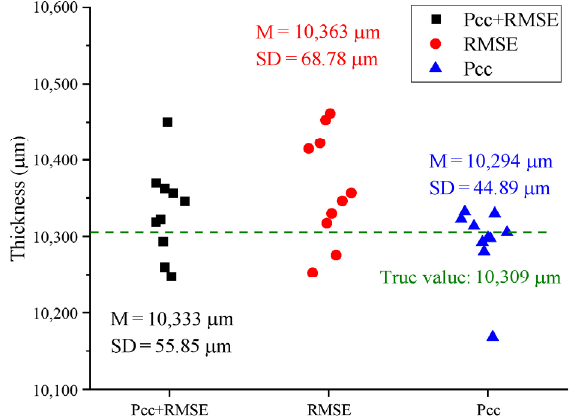
Fig. 9 Effect of different objective functions on the inversion results of thickness.